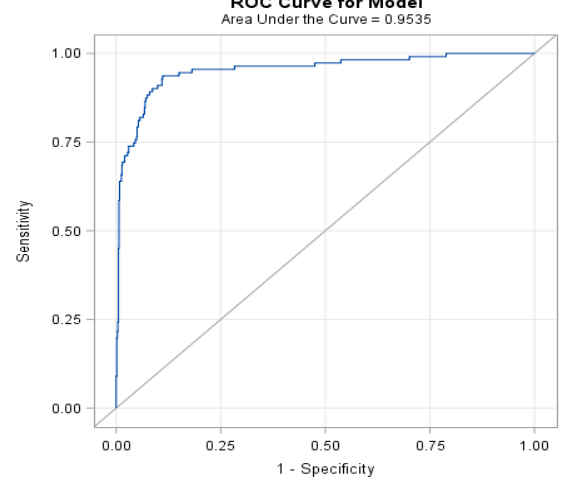
Figure 3. ROC curve.